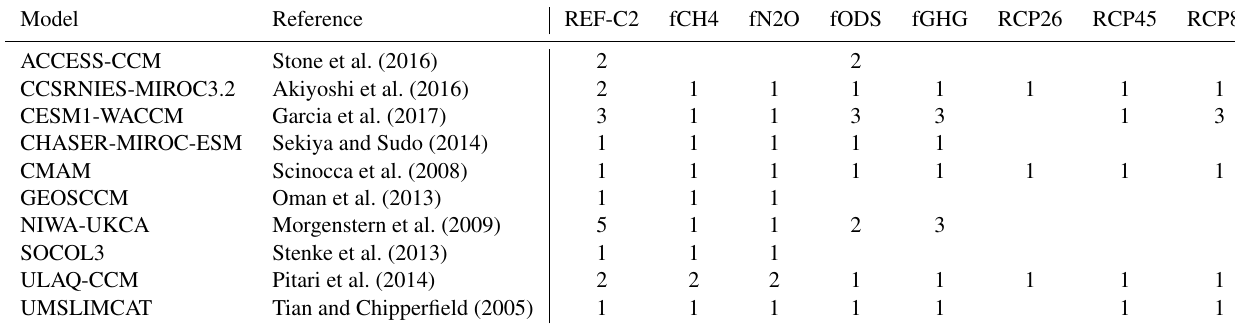
responses in ozone produced by the models. A